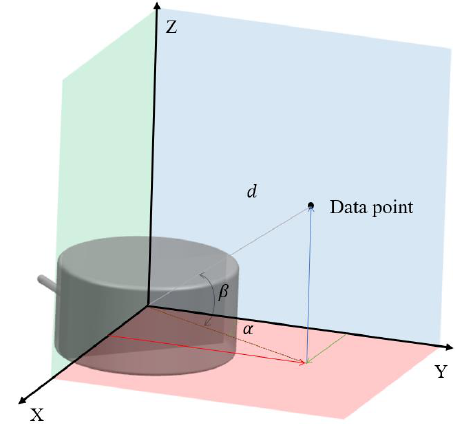
Figure 4. The point in coordinate system { A }.